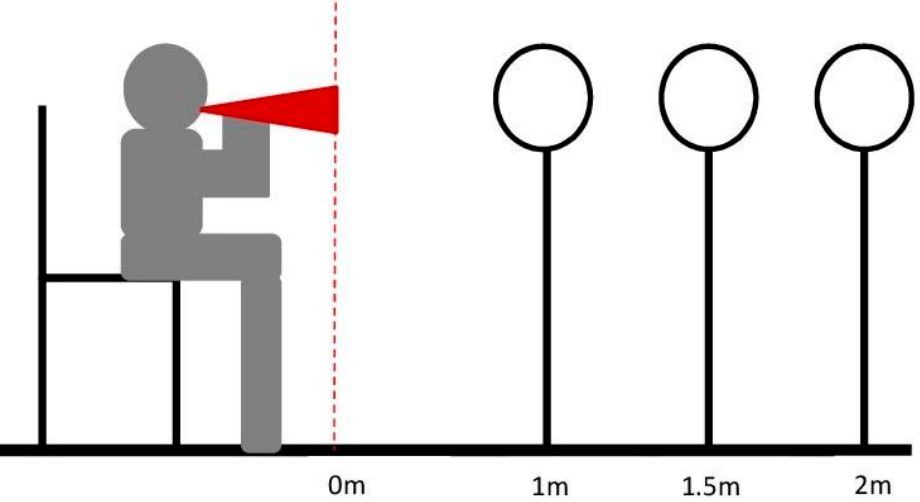
Figure A2. Distance measurements with three sensors in the direction of the instrument’s bell.